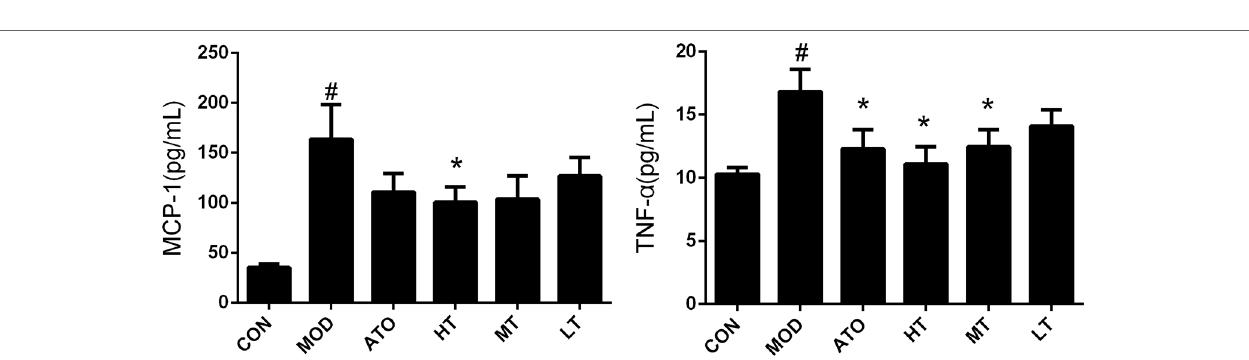
FIGURE 4 | Effect of TanIIA on the level of monocyte chemoattractant protein-1 (MCP-1) and tumor necrosis factor- α (TNF- α ) in ApoE −/− mice. Data are expressed as mean ± SEM. n = 12 (except CON group, n = 9). * P < 0.05 versus MOD group. # P < 0.05 versus CON group.